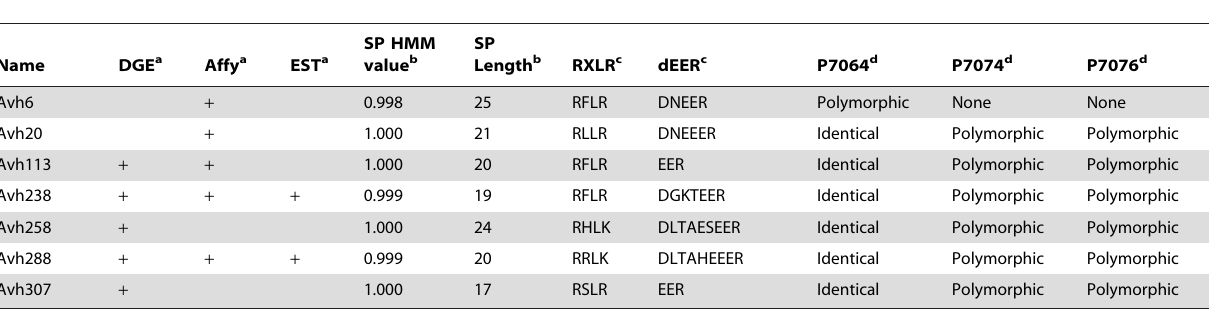
Table 1. Seven expressed RXLR effectors showed Avr3b